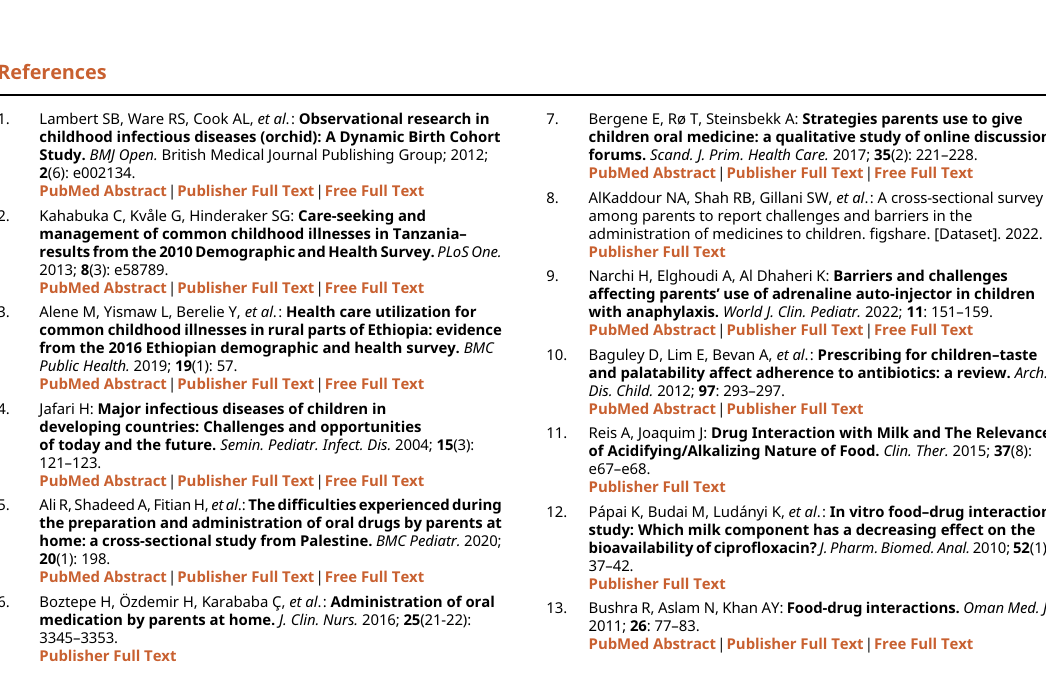
Figshare: Extended data for ‘ A cross-sectional survey among parents to report challenges and barriers in the adminis- tration of medicines to children ’ , https://doi.org/10.6084/m9.figshare.20208938.v1. 8 (cid:129) Supplementary file: Parents reported challenges and barriers in the administration of medicines among children. pdf